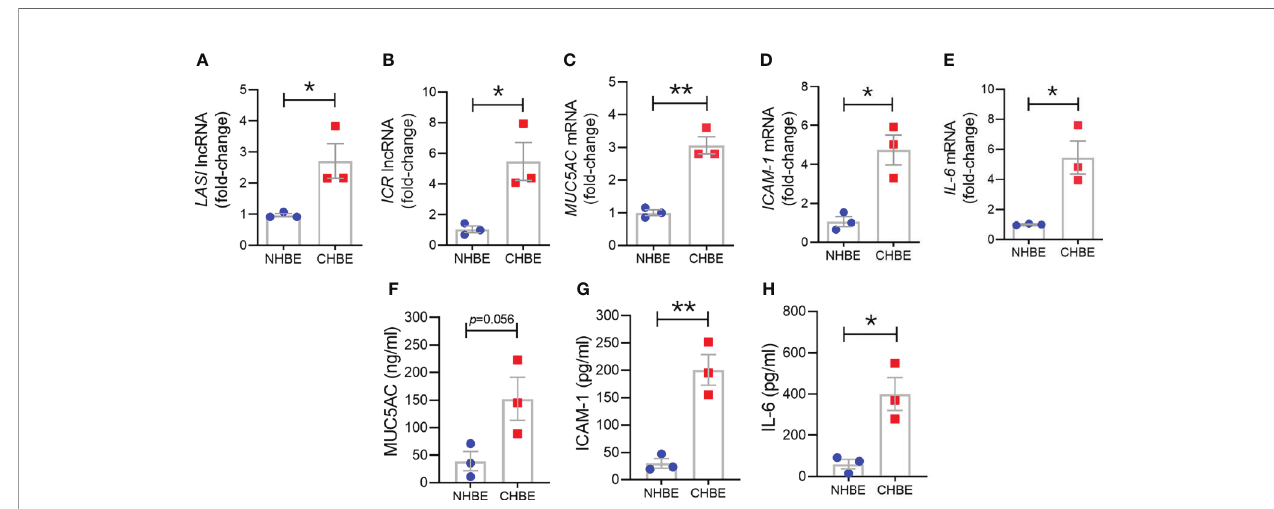
FIGURE 3 | Differentiated bronchial epithelial cells from COPD subjects show increased expression of immunomodulatory lncRNAs, MUC5AC mucin, and IL-6 and ICAM-1 compared to control cells from non-COPD donors. Relative transcript levels for lncRNA LASI (A) , and ICR (B) in 3D cultured and unstimulated NHBE and CHBE cells as determined by qRT-PCR. Relative mRNA levels of MUC5AC (C) , ICAM-1 (D) , and IL-6 (E) in fl ammatory factors. Quanti fi cation of secretory MUC5AC mucin levels (F) in the apical washes, and the secreted ICAM-1 (G) , and IL-6 (H) levels in basal media supernatant as analyzed by speci fi c sandwich ELISA assays. Data shown as mean ± SEM as fold-change over NHBEs; n = 3/gp; data analyzed by student ’ s t-test; * p <0.05; ** p <0.01.